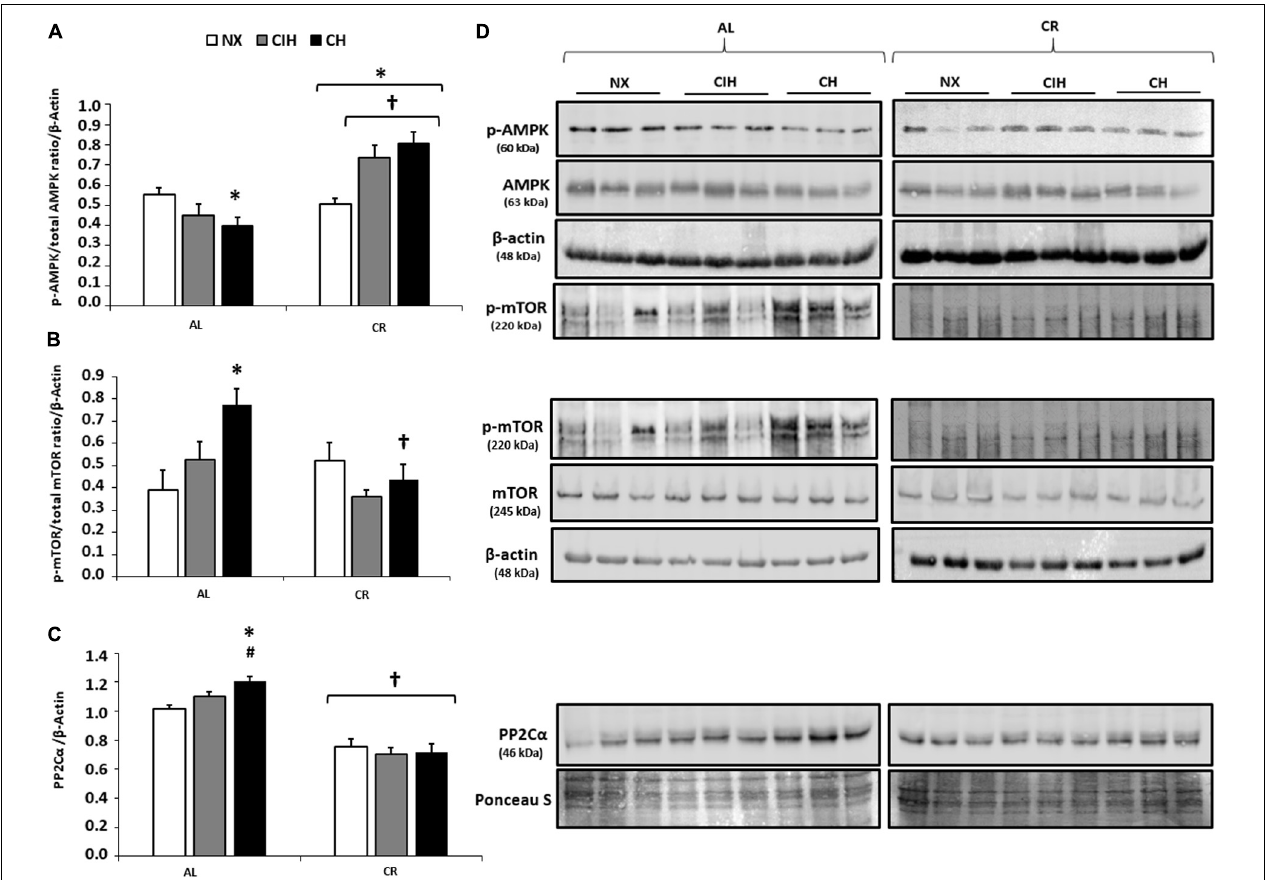
FIGURE 3 | Protein expression levels in the right ventricle (RV): Ad libitum (AL) and caloric restriction (CR) groups at day 30: normoxic group (NX), chronic intermittent hypoxia group (CIH), and chronic hypoxia group (CH). (A) Activation of AMPK (p-AMPK/total AMPK ratio); (B) Activation of mTOR (p-mTOR/total mTOR ratio) normalized by β -actin; (C) PP2C α expression levels, normalized by Ponceau staining; and (D) Representative bands are shown. Values are means (X) ± standard errors (SEs). ∗ p < 0.05: hypoxia-exposed vs. NX; # p < 0.05: CIH vs. CH. † p < 0.05: AL vs.